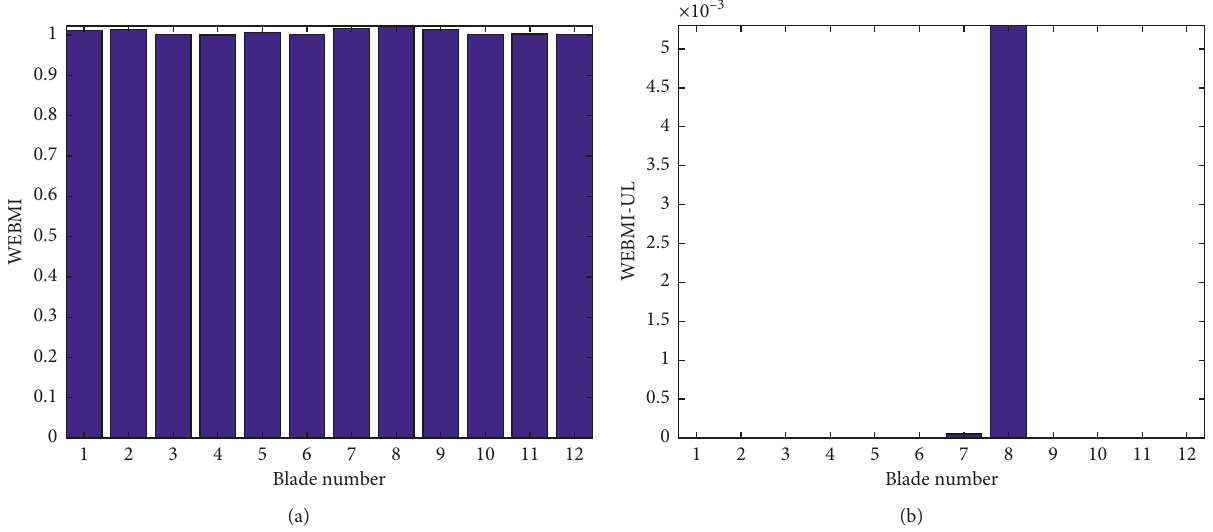
Figure 16: PECS results for the added mass located at blade 8. (a) WEBMI and (b)